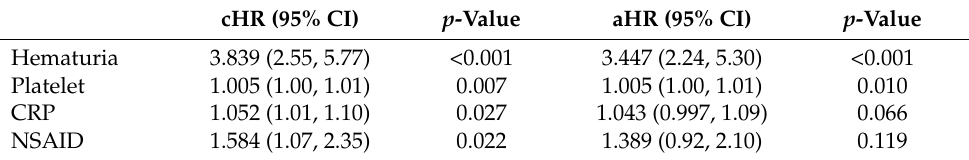
Table 4. Effects of hematuria on a 50% decline in eGFR during a five-year